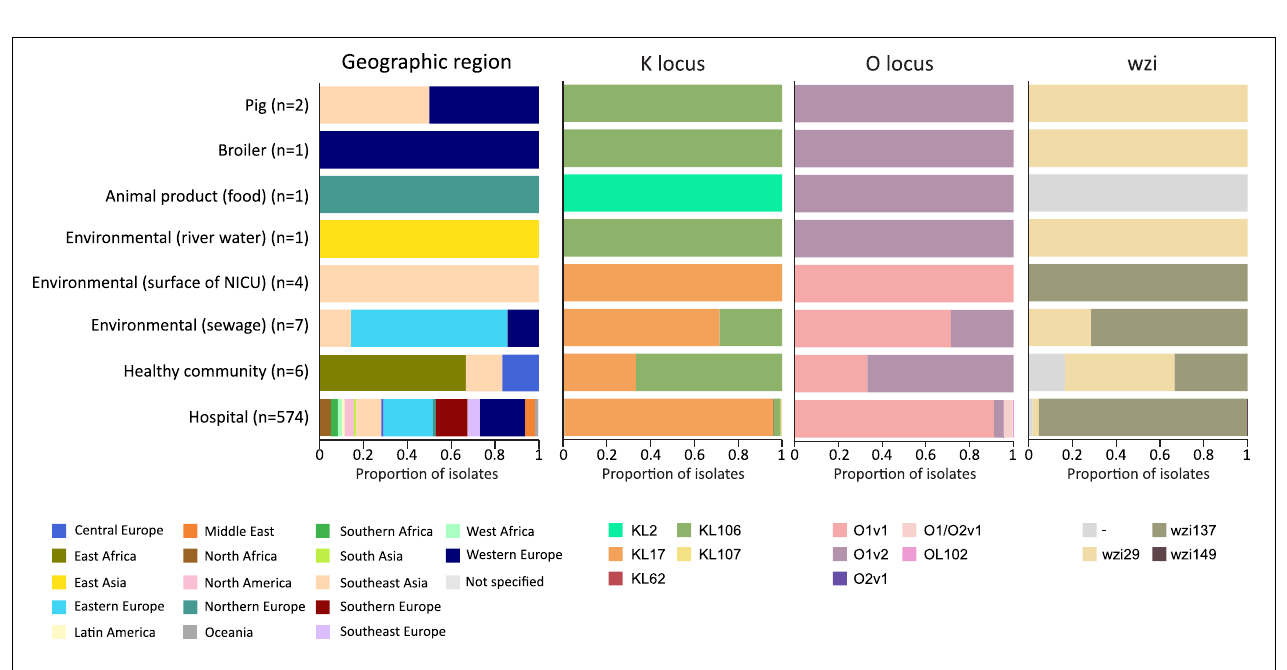
FIGURE 2 | Heatmap of the most common plasmid origins of replication detected in K. pneumoniae ST101 based on screening against the PlasmidFinder database using BLASTn. Replicon markers shown are those with prevalence > 10% in one or more origin categories. Graphs and heatmaps show the proportion of isolates, numbers in the heatmaps indicate the number of genomes containing the resistance gene.